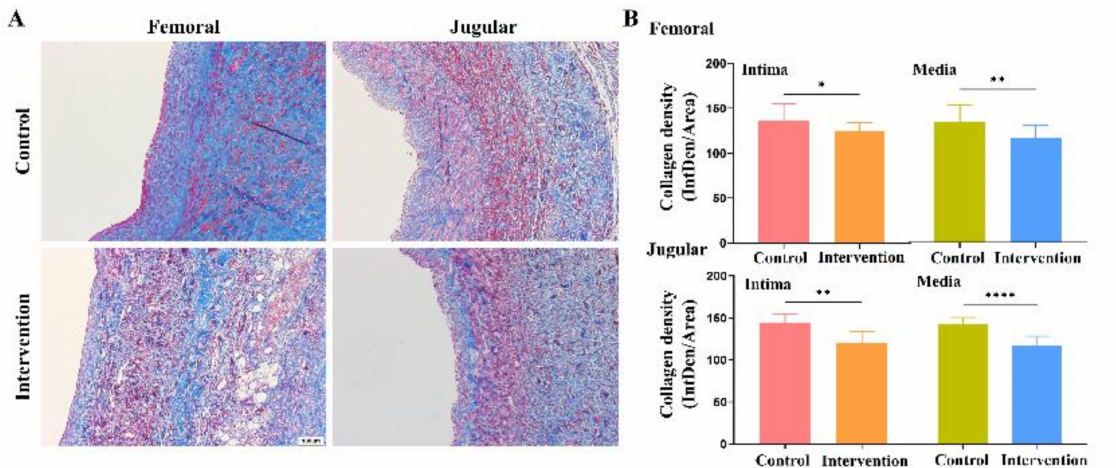
Figure 6. Collagen density of vein graft. ( A ) The collagen density (blue color) analysis with Masson’s